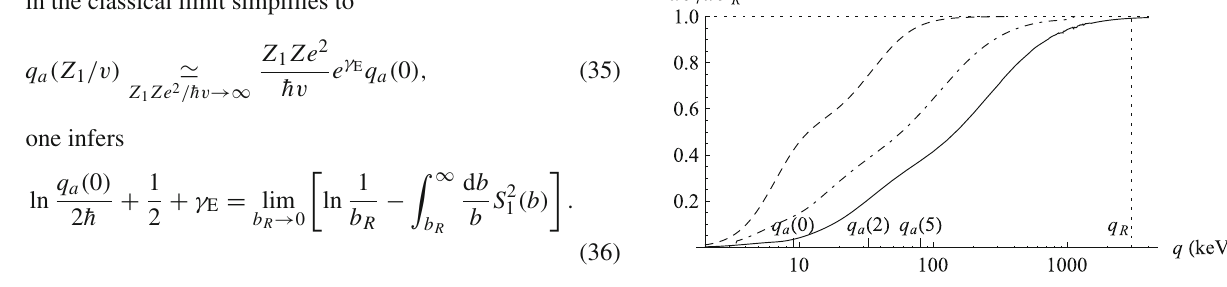
Fig. 1 d σ , differential cross section (7), (8) of eikonal scattering in the mean potential of a carbon atom ( Z = 6), based on the parametrization [28] for the Hartree–Fock electron density. Plotted is the ratio of d σ to the corresponding pure Rutherford scattering cross section d σ R vs. the momentum transfer (log scale). Dashed, perturbative scattering regime ( Z 1 Ze 2 / ¯ h v = 0 . 1). Dot-dashed, Z 1 Ze 2 / ¯ h v = 2. Solid, Z 1 Ze 2 / ¯ h v = 5. The latter two curves in fact already belong to the semiclassical scattering regime, thus differing by a pure translation in log q . For any curve, the area between it and the dashed one equals the corresponding Coulomb correction to ln q a . Ticks q a ( 0 ) , q a ( 2 ) , and q a ( 5 ) show values of Molière’s screening momentum evaluated by Eq. (20), for values of the Coulomb parameter indicated in the parentheses. Tick q R shows a possible position of the cutoff in formula (20), which can be used for all Coulomb parameters up to 5